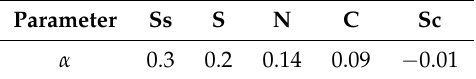
Table 4. Proposed wind shear exponent